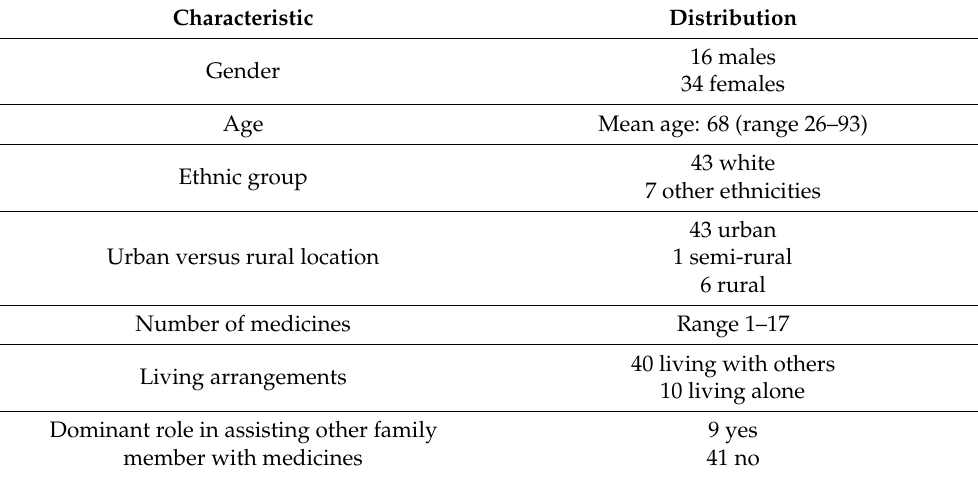
Table 1. Participants’